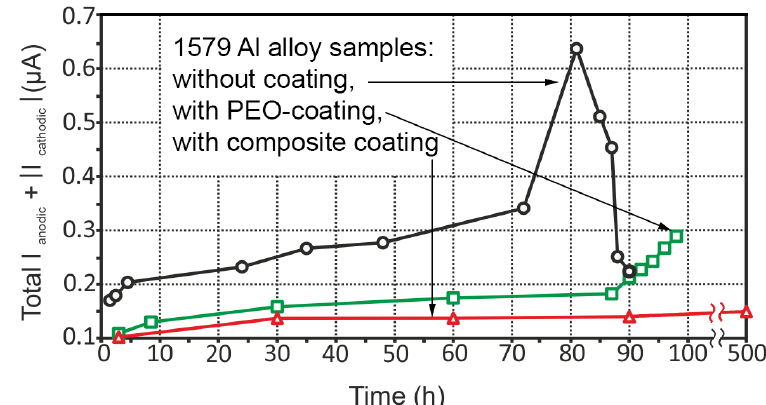
Figure 9. The evolution of the sum of the total cathodic and anodic currents for three aluminium alloy samples (without coating, with PEO-layer, with composite polymer-containing coating). The sample with the composite coating has the lowest values of the activity with the maximum value of total currents of 0.15 µA after 500 h of sample exposure.